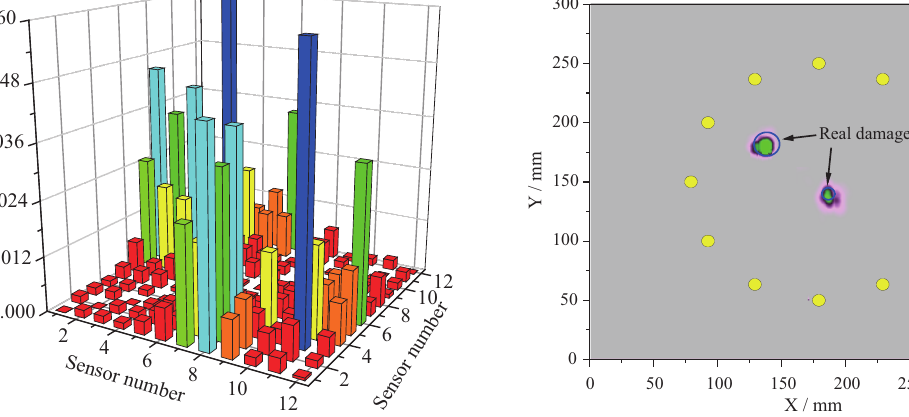
Fig. 16. Damage image of the composite with two